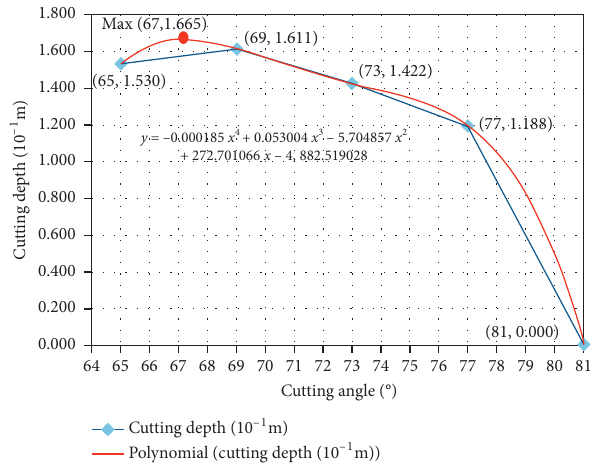
Figure 9: Fitting curves of wedge cutting models with different angles and blasting